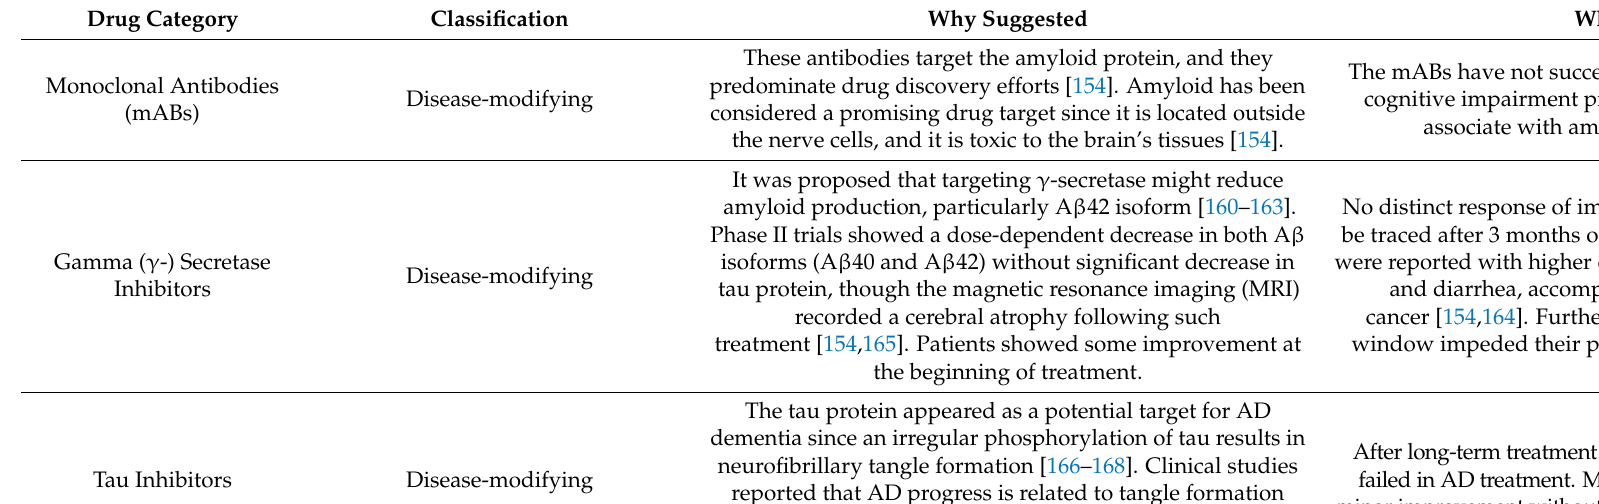
Table 4. Most important drug classes that failed as anti-AD treatments in different stages of clinical